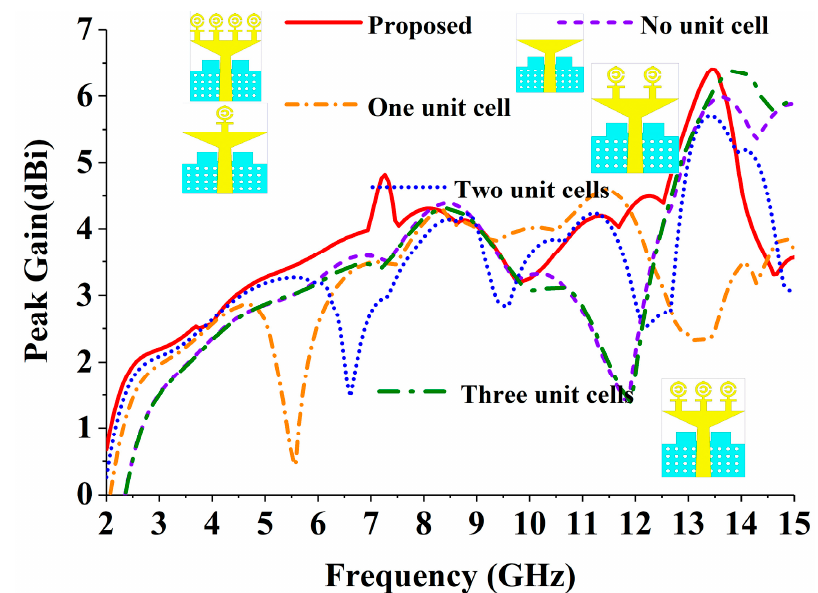
Figure 6. The effects of the unit cell of the radiating patch on the peak gain.